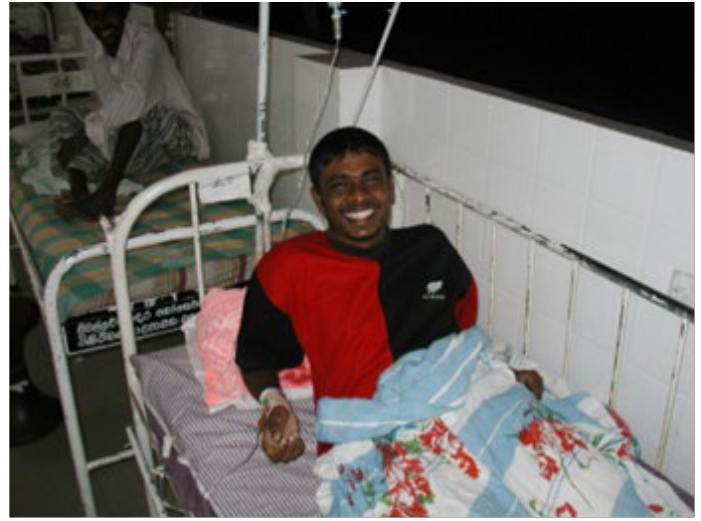
Figure 1 . A study patient on the second day after his recruitment to the charcoal study, 2002. Image by the author Michael Eddleston, with consent from the study participant.